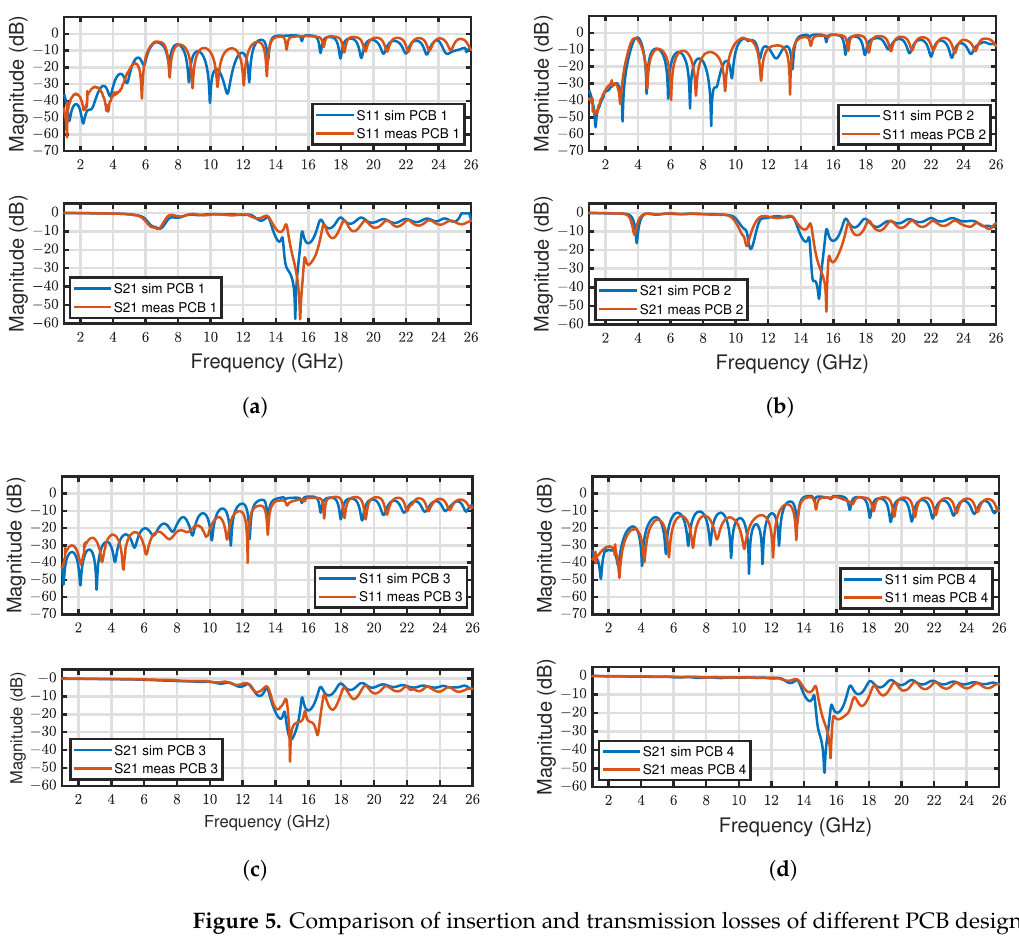
Figure 5. Comparison of insertion and transmission losses of different PCB designs (see Figure 3).